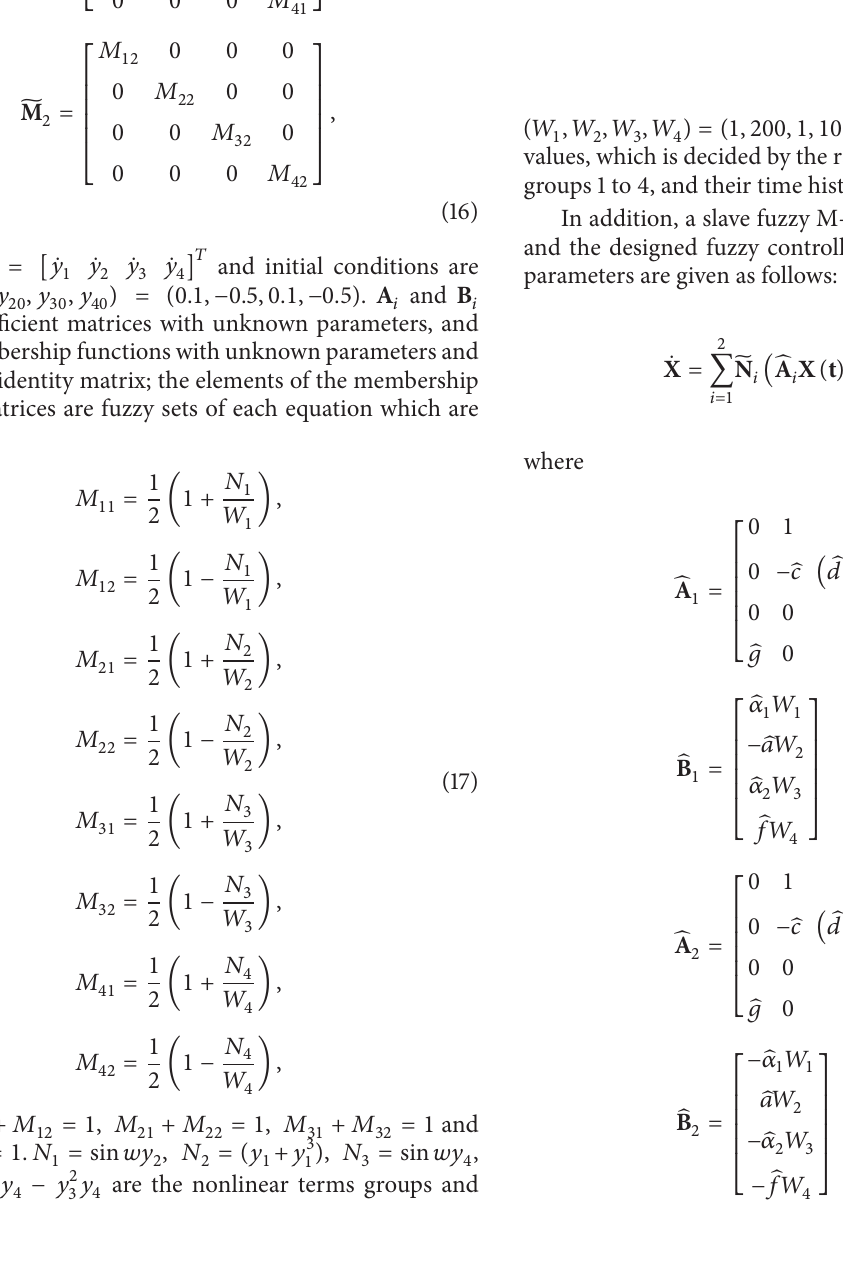
Figure 2: Time series of nonlinear terms groups in Mathieu-Van der pol system with